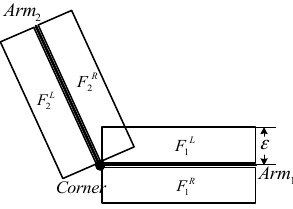
Figure 2. Edged corner feature (corner and its arms) and flanking regions.